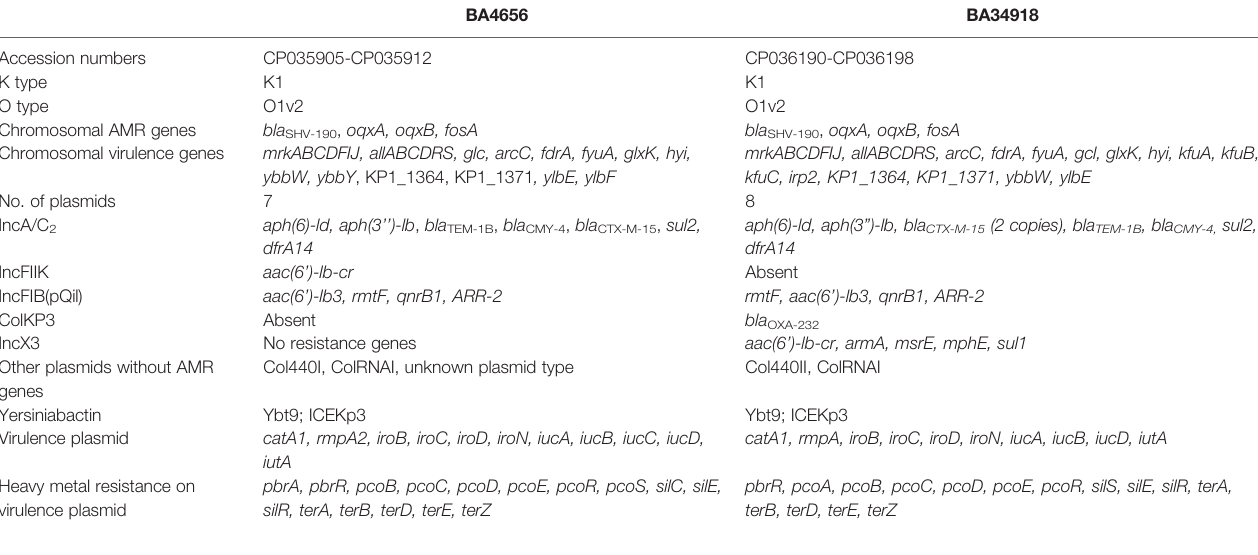
TABLE 1 | Characteristics of the two multidrug resistant (MDR) hypervirulent Klebsiella pneumoniae isolates belonging to